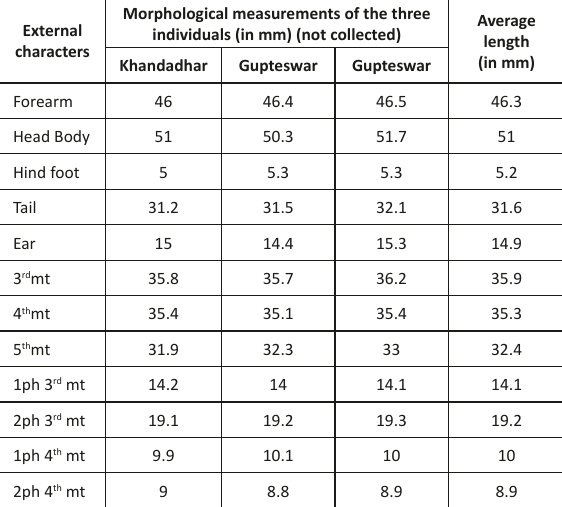
Table 1. Detailed morphological measurements of H.